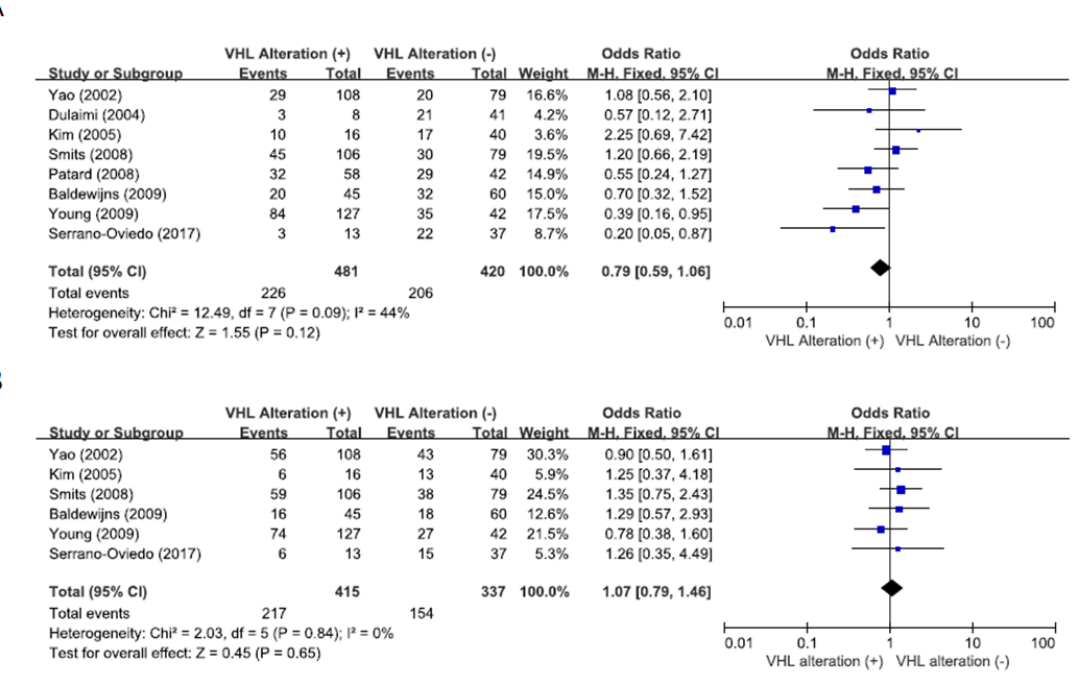
Figure 2. Forest plots for the association between VHL alteration and pathological features. ( A ) Nuclear grade. ( B ) Disease stage.